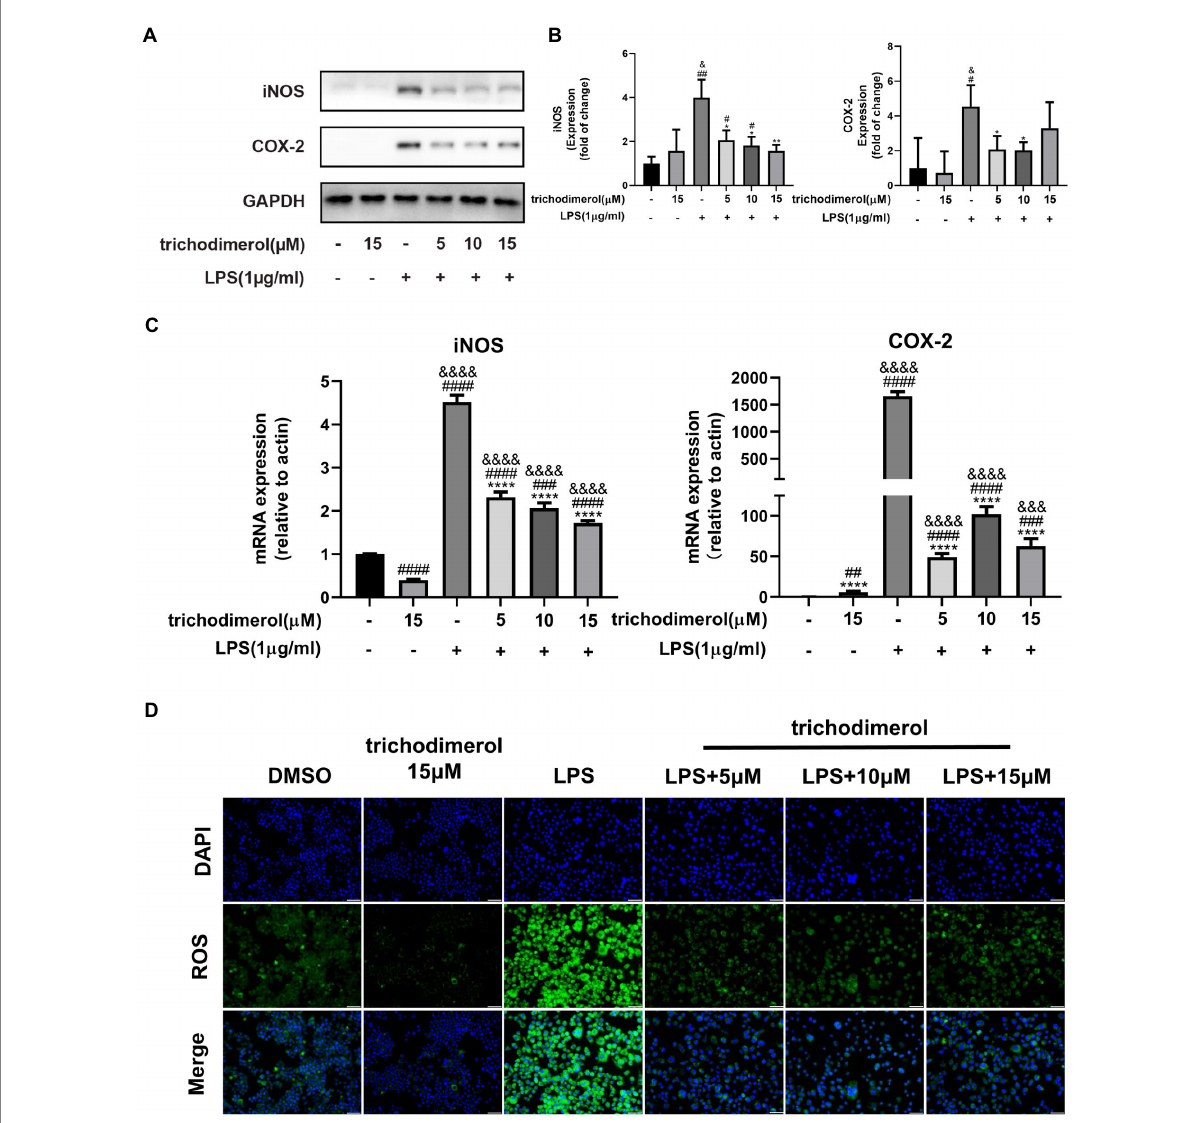
FIGURE 3 The effect of trichodimerol on the inflammatory mediators. (A) The protein expression of inducible nitric oxide synthase (iNOS) and cyclooxygenase (COX)-2 in RAW264.7 macrophages treated with different concentrations; GAPDH was used as an internal reference. (B) Quantitative statistical results of the protein expression of iNOS and COX-2. (C) mRNA expression levels of iNOS and COX-2 in RAW264.7 macrophages in different treatment groups. (D) Reactive oxygen species (ROS) production in RAW264.7 macrophages induced by LPS 24 h after trichodimerol treatment. Green fluorescence represents intracellular ROS stained by DCFH-DA, blue fluorescence represents nucleus, white stripe = 50 μ m. All data are expressed as the mean ± SD. # p < 0.05, ## p < 0.01, ### p < 0.001, and #### p < 0.0001, compared with the DMSO group. & p < 0.05, &&& p < 0.001, and &&&& p < 0.0001, compared with the trichodimerol 15 μ M group. * p < 0.05, ** p < 0.01, and **** p < 0.0001, compared with the LPS